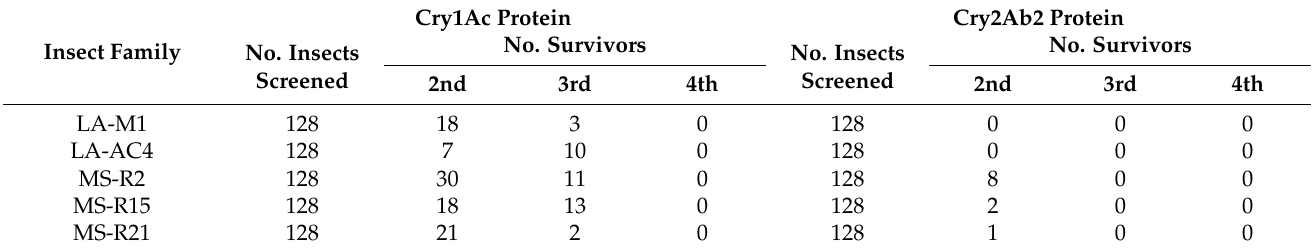
Table 7. Survivors of Vip3Aa resistant families of Helicoverpa zea on Cry1Ac and Cry2Ab2 proteins in the F 2